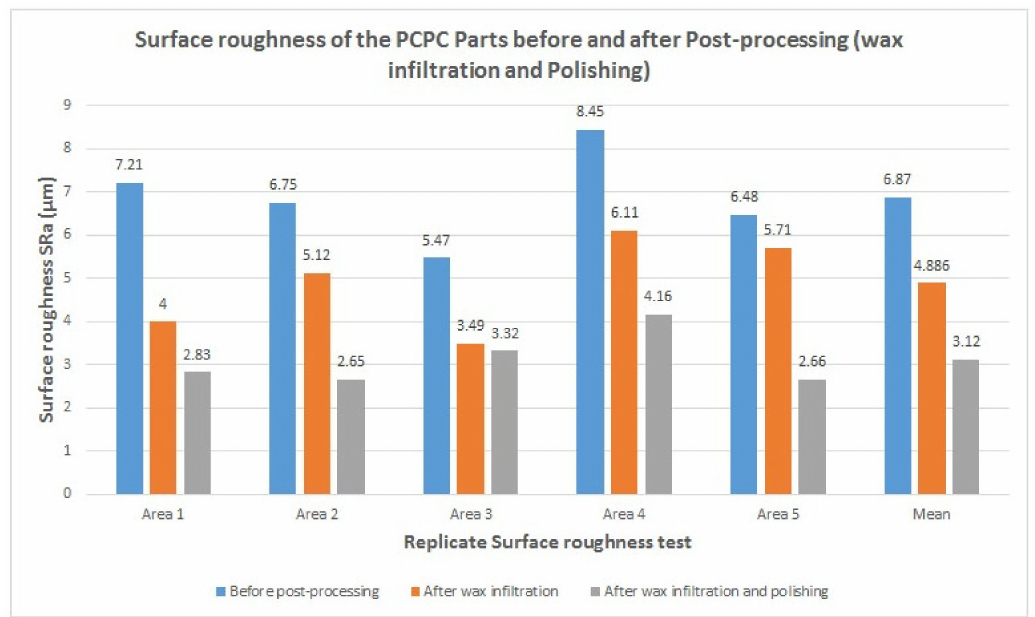
Figure 12. Surface roughness of the PCPC parts before and after post-processing (wax infiltration and